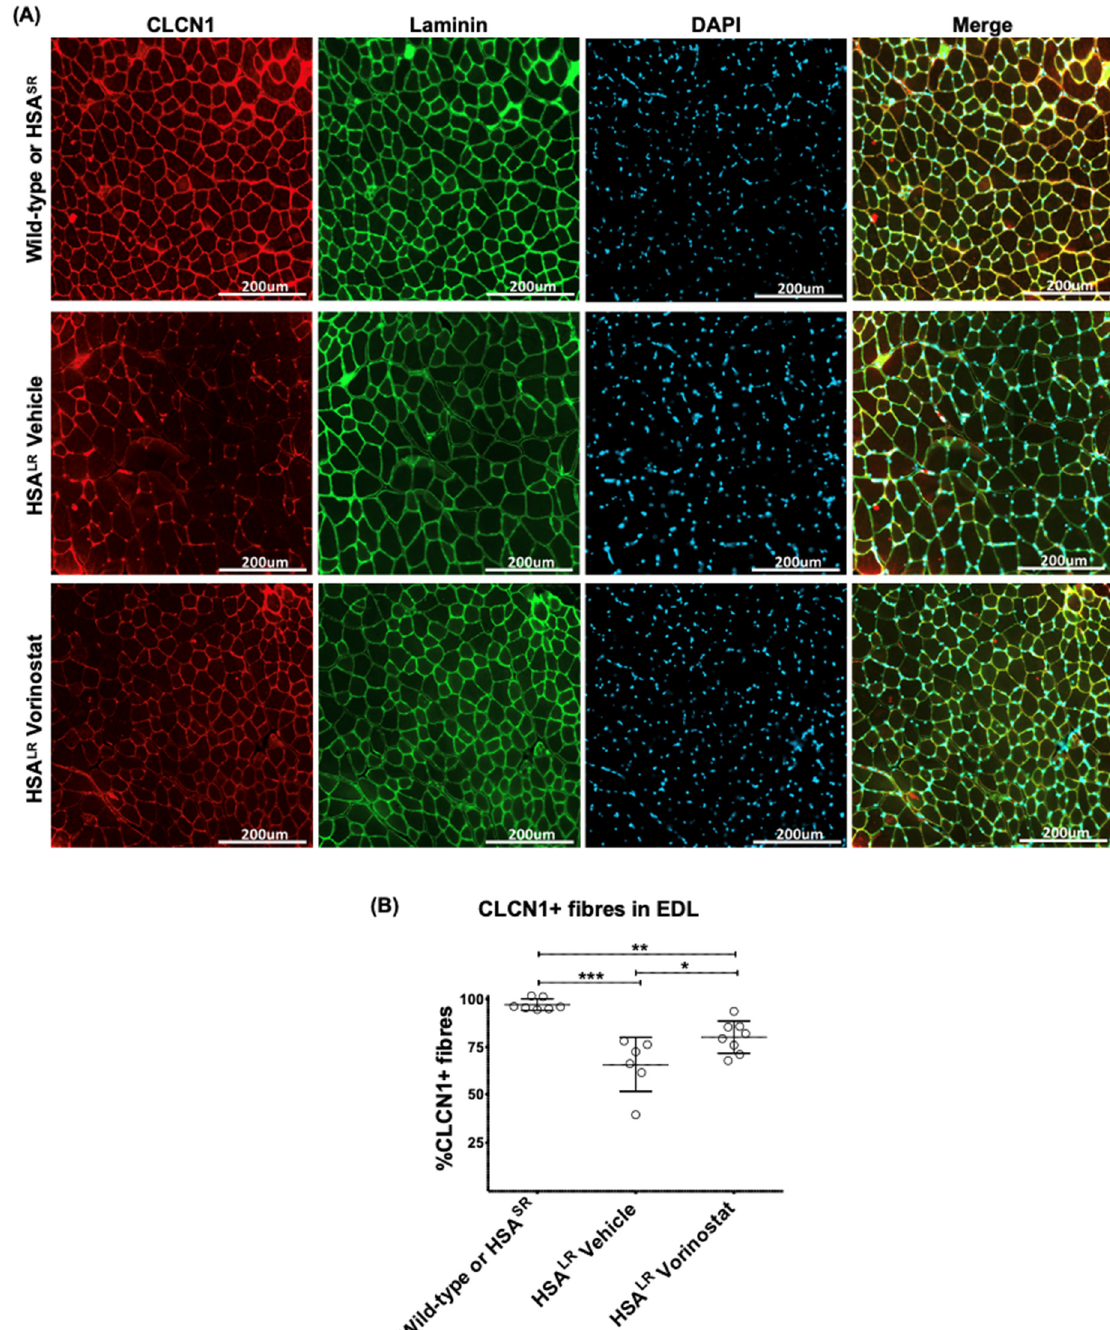
(SAHA) for 4 weeks. The mice were sacrificed by lethal injection and cervical dislocation. Skeletal muscle tissue from one hind leg was frozen in OCT for sectioning and imaging, and central nucleation was assessed in ( A ) TA and ( B ) EDL muscle. Tissues flash frozen in OCT were sectioned at 10 µ m thickness and subjected to H&E staining. Brightfield images were taken at 20 × using EVOS cell imaging system and whole sections were manually counted for central nucleation. ( n ranges from 6 to 8, two-way ANOVA; error bars represent SD). * p < 0.05, ** p < 0.01, *** p < 0.001. Abbreviations, EDL, extensor digitorum longus ; ns, not significant; TA, tibialis anterior .